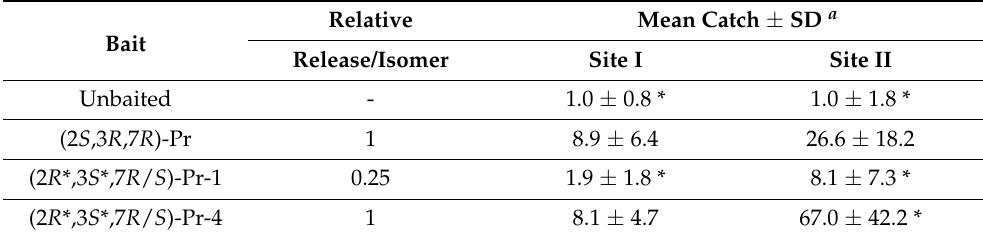
Table 3. Catch of male Diprion similis in traps baited with propanoate (-Pr) of (2 S ,3 R ,7 R )- 3,7-dimethylpentadecan-2-ol (diprionol), alone or in combination with the three other (2 R *,3 S *,7 R / S